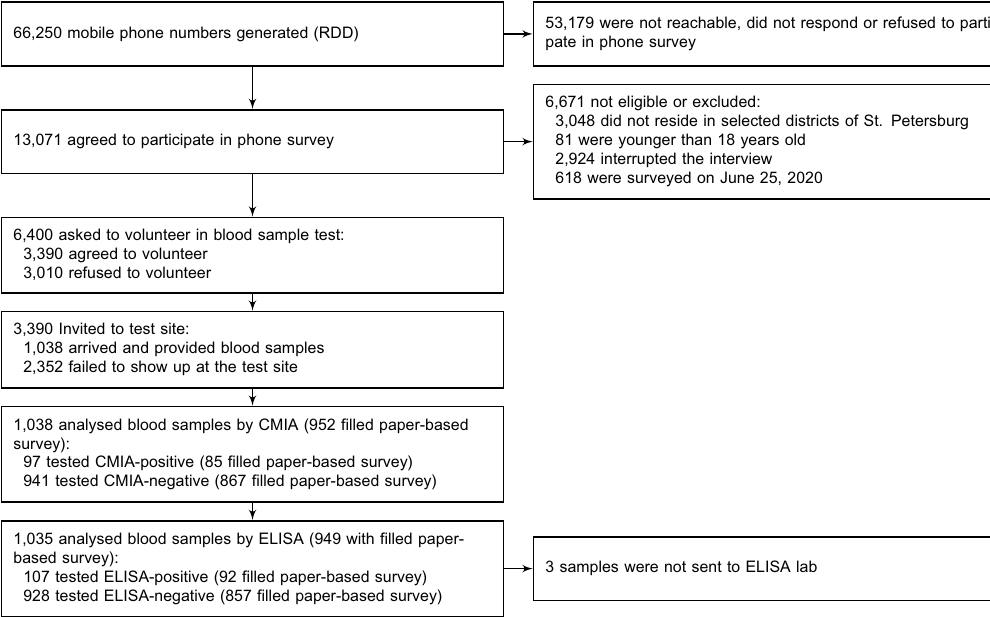
Figure 1. Flow chart of participants’ progress through the St. Petersburg seroprevalence